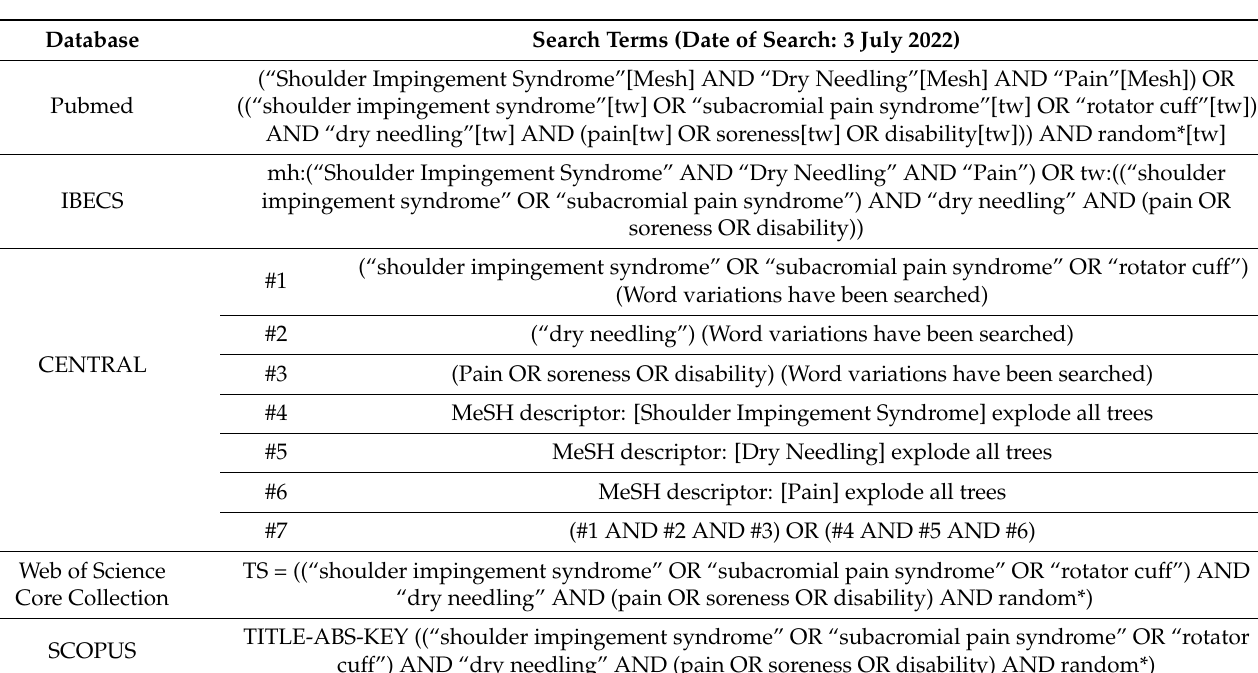
Table A1. Search